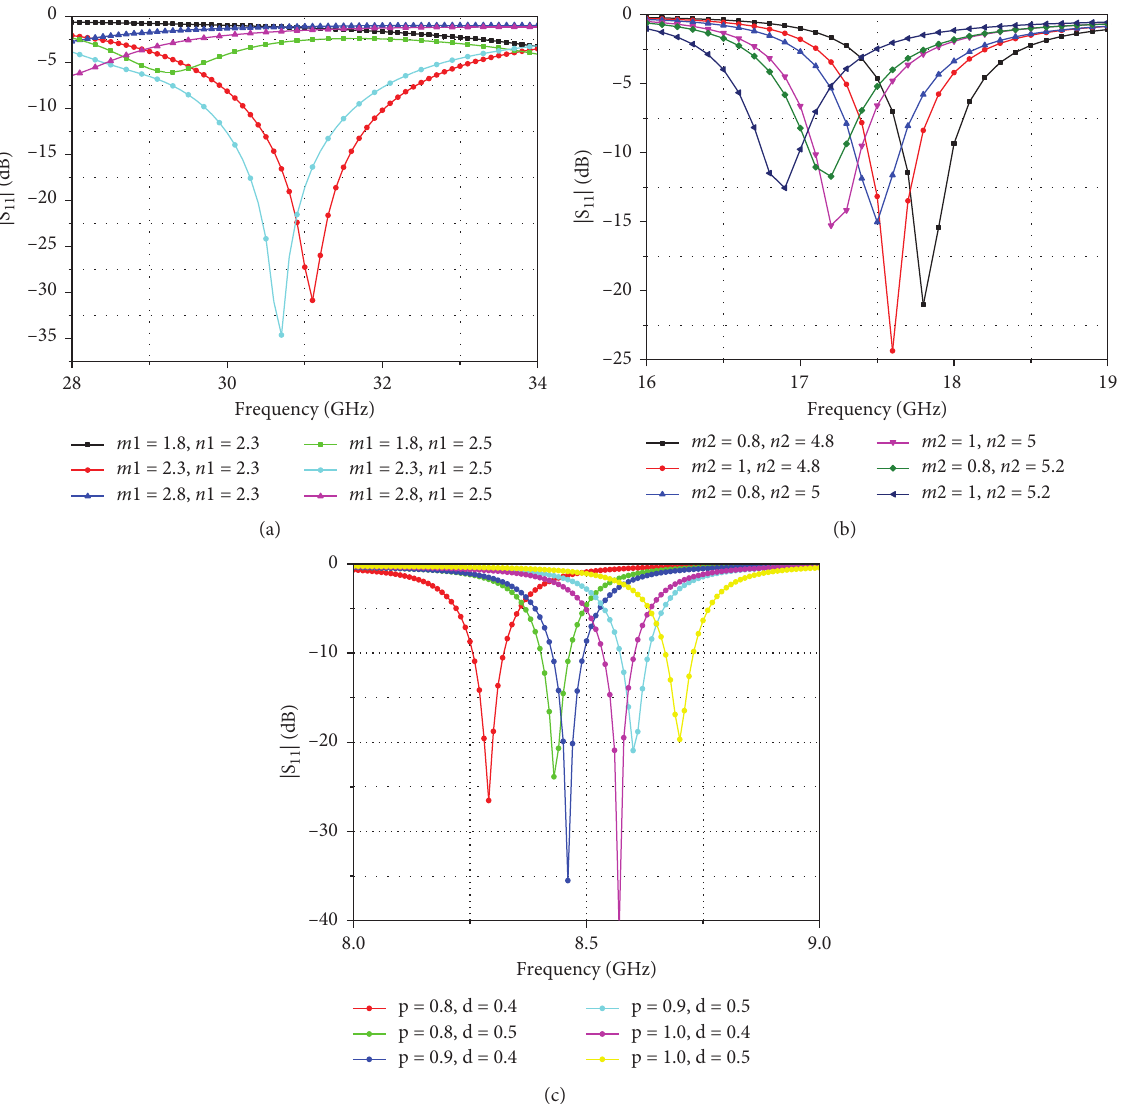
Figure 2: Optimized results of the three radiators. (a) Ka-band. (b) Ku-band. (c)